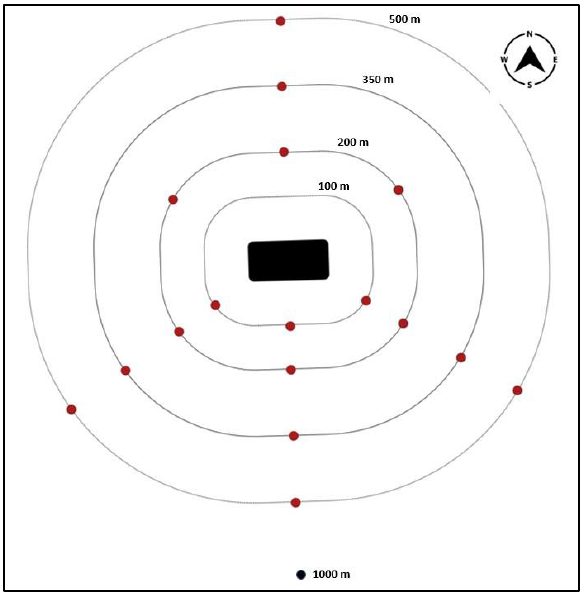
Figure 3. Sediment sampling stations monitored from 2010 to 2015 at several distances from the LNG terminal. Sampling station located 1000 m south (black dot) is not in scale.